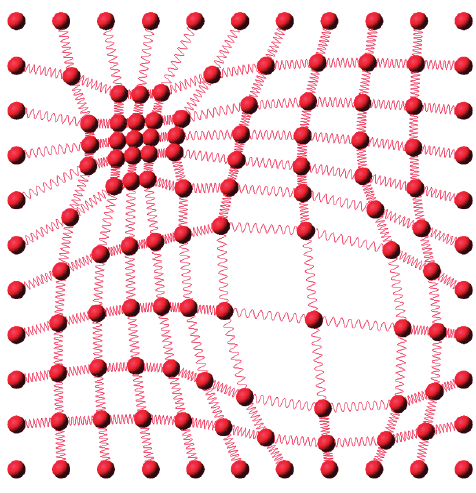
Figure 5. Configured sensor nodes.